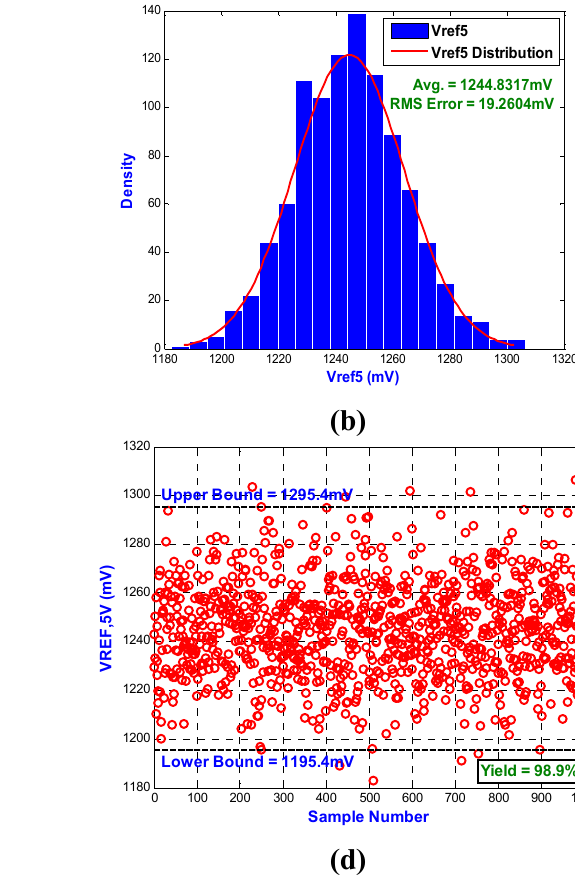
(c) scatterplot of voltage references, REF ,5 V . REF ,5 V